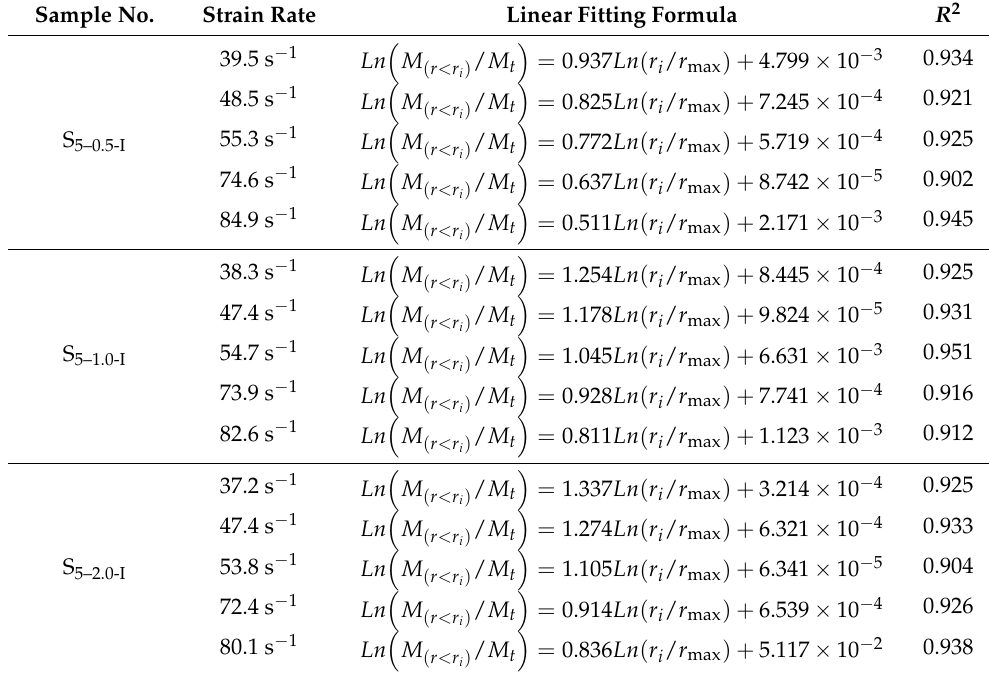
Table 3. Fractal fitting of cemented rock samples with different strain rates. Sample No.